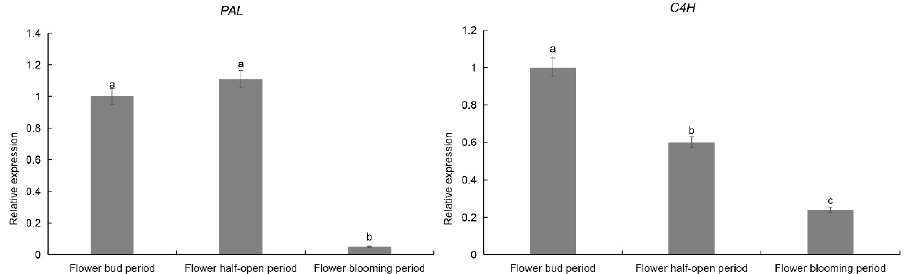
Figure 8. Expression patterns of PAL and C4H at three different flowering period in high-scent D. loddigesii . D. loddigesii